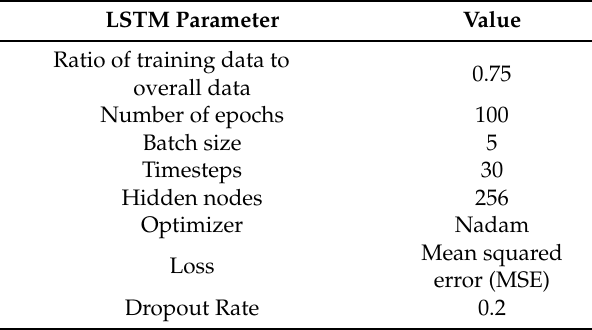
Table 2. LSTM parameter